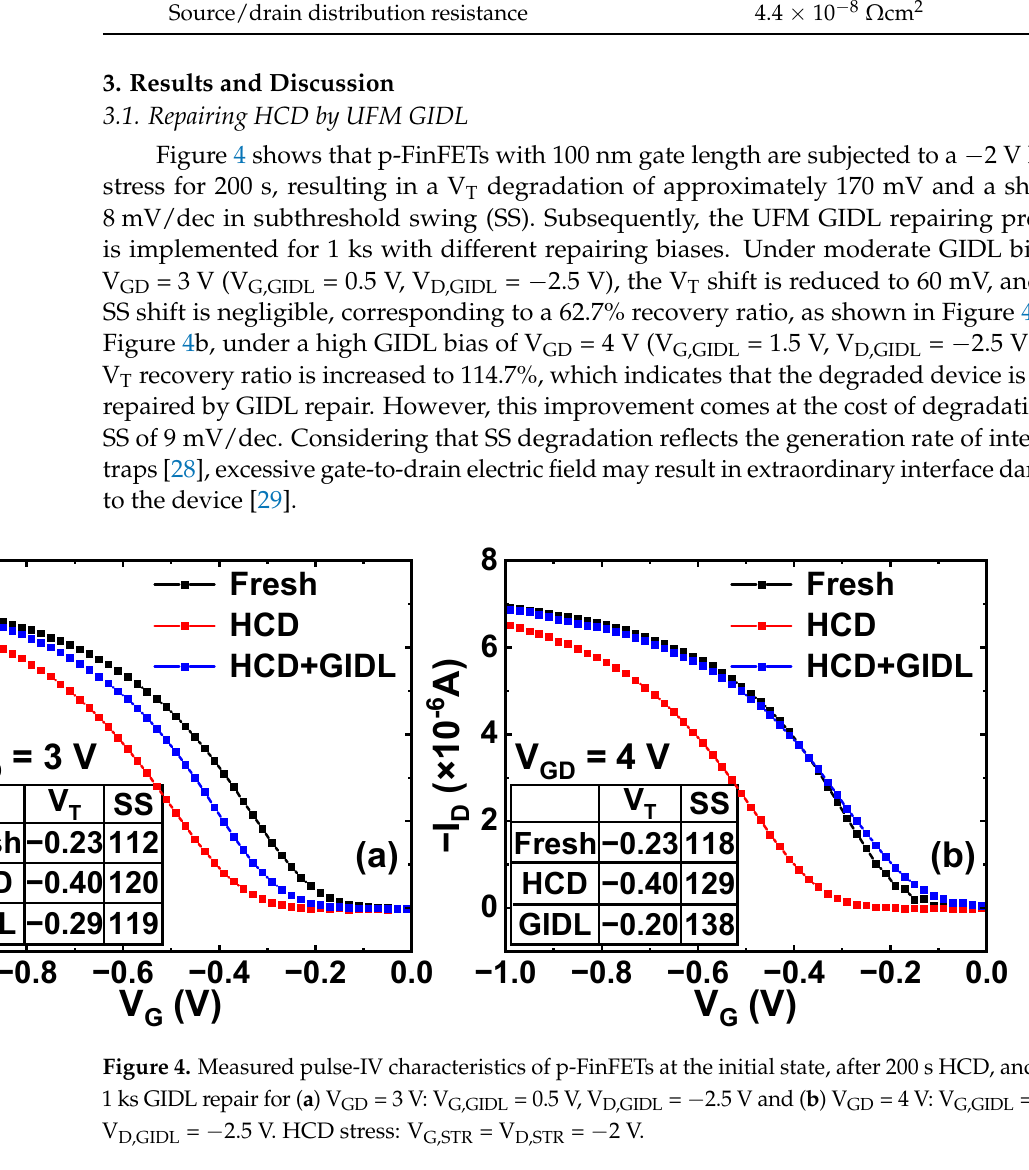
Figure 3. ( a ) 3-D simulation structures of Bulk FinFET with 100 nm gate length. ( b ) TCAD calibration of Bulk FinFET I D -V G and GIDL characteristics with experimental data. Orange curve: V D = − 3.5 V. Green curve: V D = − 3.0 V. Blue curve: V D = − 2.5 V.